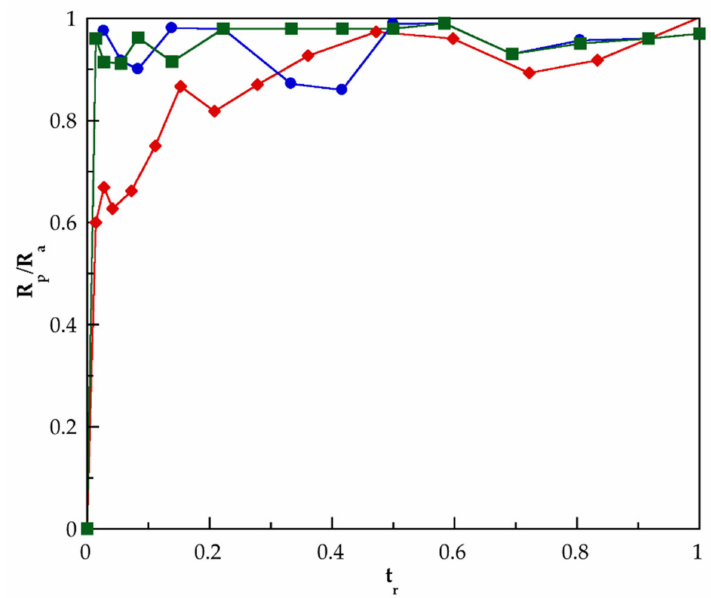
Figure 3. Evolution of the rate of polymerization to monomer feeding rate ( R p /R a ) in function of normalized time for polymerization of MAA to prepare the PMAA 2 ( (cid:7) ) or for the polymerization of a mixture of MAA and G 3.0 -CNTs-PAMAM-NH 2 to obtain the nanocomposites PMAA–CNTs 3 ( (cid:4) ) and PMAA–CNTs 4 ( • ) at a monomer feeding rate of 0.1 g/min.